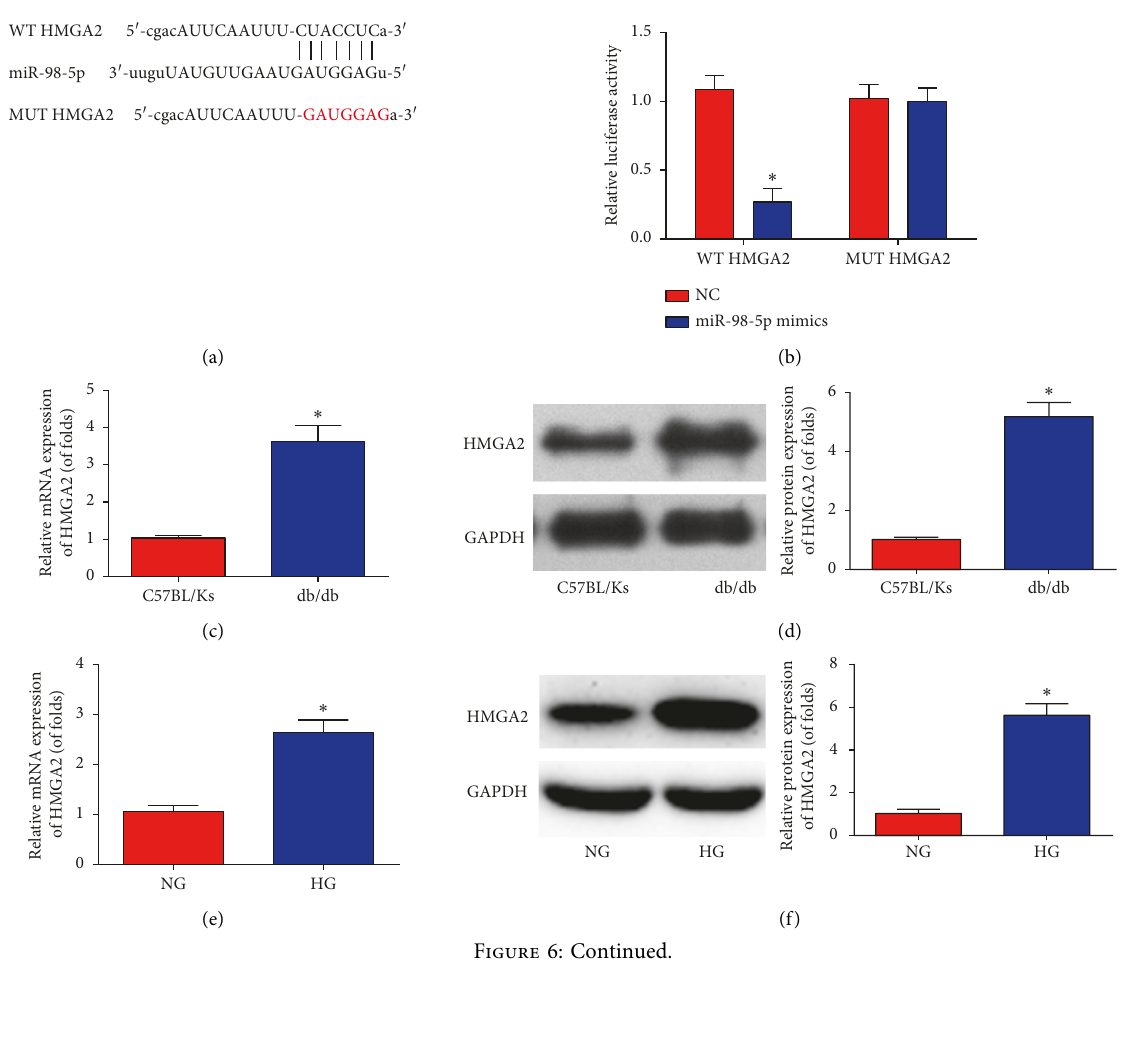
SD of at least triplicate ±